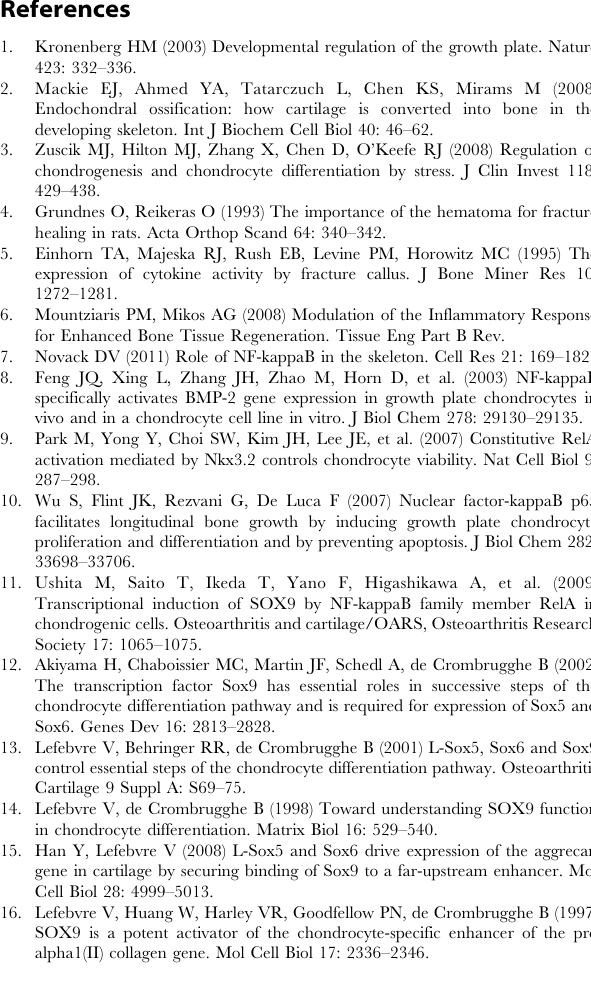
Figure S1 NF- k B/p65 nuclear translocation during early ATDC5 differentiation. Figure S2 In silico scan for NF- k B/p65 transcription factor binding sites in the Sox9 promoter. Figure S3 Chondrogenic differentiation is enhanced by stimulation of NF- k B/p65 activity. Figure S4 NF- k B signaling during chondrogenic differ- entiation of hBMSCs.